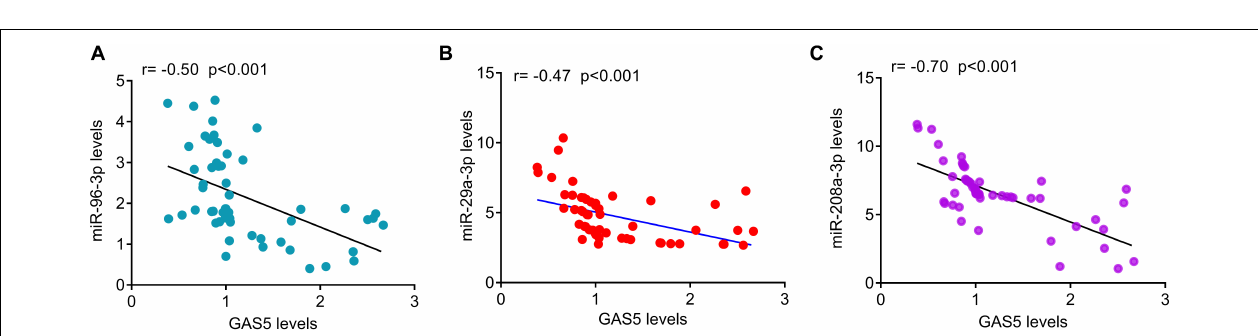
FIGURE 1 | The serum levels of GAS5 and miRNAs in patients with type-2 diabetes and healthy control subjects. (A) QPCR was performed to determine the serum levels of GAS5, miR-29a-3p, miR-96-3p, miR-208a-3p, miR-452-5p, and miR-221-3p in patients with type-2 diabetes and healthy control subjects. (B) The serum levels of miRNAs in low GAS5 group and high GAS5 group according to the mean level of GAS5 in patients with type-2 diabetes. Data were presented as mean ± SD. T2DM, type-2 diabetes mellitus; ns, no significant. * p < 0.05, ** p < 0.01 vs. healthy control.